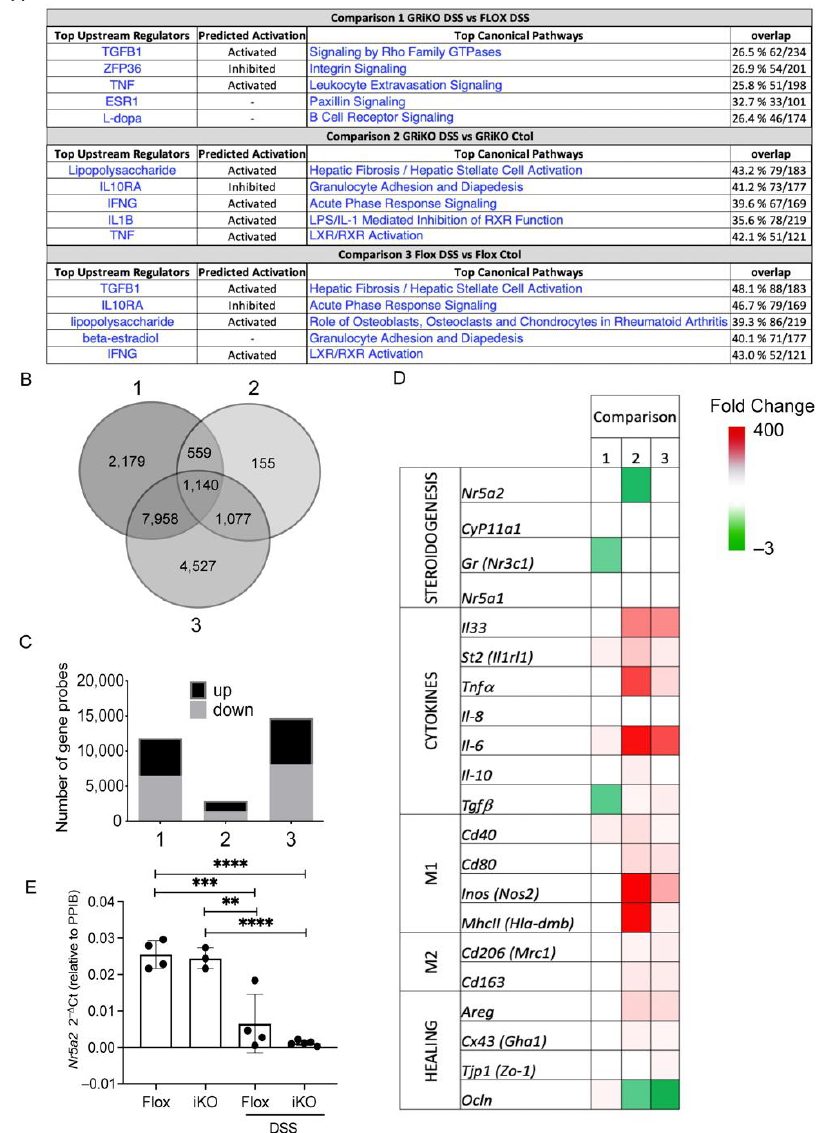
Figure 3. Epithelial GR modulates gene expression in intestinal mucosa from DSS-treated mice. ( A ) Top five upstream regulators and canonical pathways from gene expression microarray in GR iKO DSS vs. GR flox DSS (Comparison 1), GR iKO DSS vs. GR iKO Ctol (Comparison 2), and GR flox DSS vs. GR flox Ctol (Comparison 3) using Ingenuity Pathway Software (IPA); ( B ) Venn diagram of the overlap in significant gene probes determined from 3 comparisons; ( C ) Number of gene probes either induced ( up ) or repressed ( down ) by each comparison; ( D ) Gene probes that showed statistically significant differences for any of the three comparisons and that affected immune response and steroidogenesis pathway were selected and grouped into five categories: (1) steroidogenesis, (2) cytokines, (3) M1-like markers, (4) M2-like markers and (5) re-epithelialization. The heatmap indicates increased (red/upregulated) or decreased (green/downregulated) expression levels. Two- way ANOVA ( p < 0.05); ( E ) Nr5a2 transcript (relative to Ppib ) from colonic samples from each mice group. one-way ANOVA with Tukey’s post-test.** p < 0.01, *** p < 0.001, **** p <